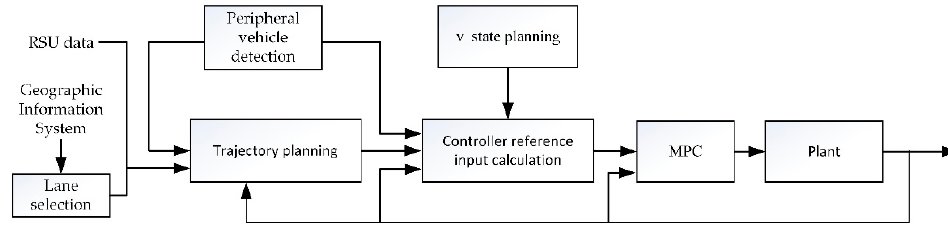
Figure 2. System structure of turning vehicle for ADV.